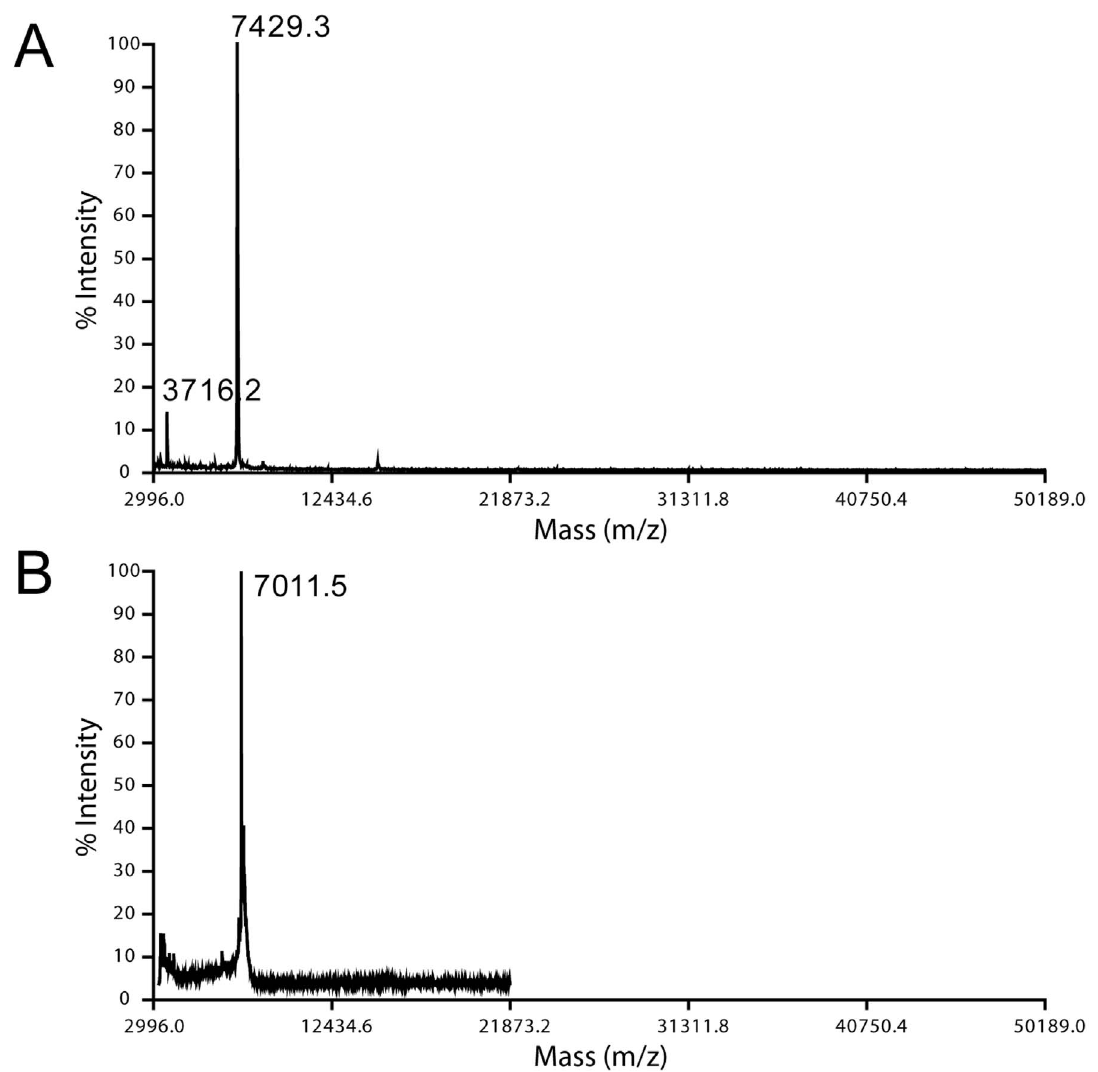
Figure 2. Mass spectrometry of recombinant and synthetic p7 protein. MALDI mass spectra corresponding to the HPLC fraction indicated in Fig. 1E (expected MW 7421.9 Da) (A) and synthetic p7 (expected MW 7017.5 Da) (B). In (A), a double-charged peak also appears at half the expected mass.